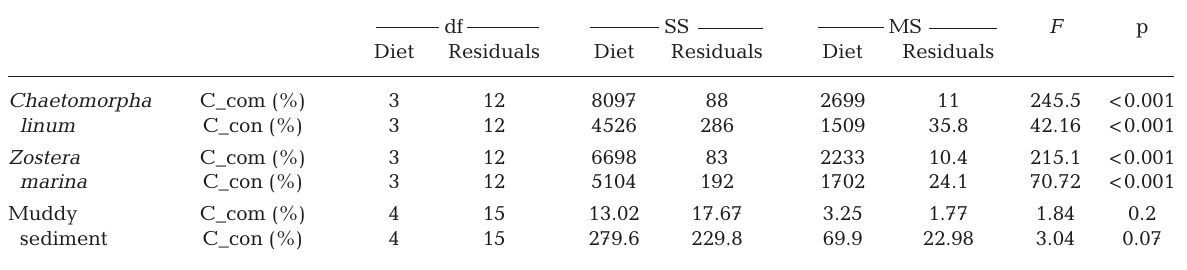
Table 7. Results of ANOVA for C_com and C_con (as defined in Table 6) of ingredients in the 5 experimental diet